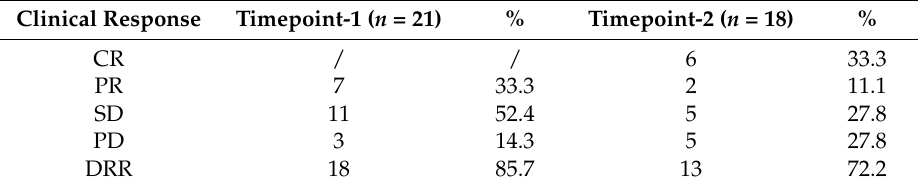
Table 4. Clinical response assessment according to the modified Response Evaluation Criteria for Solid Tumors (mRECIST) at timepoint-1 and timepoint-2. CR, Complete Response; PR, Partial Response; SD, Stable Disease; PD, Progressive Disease; DRR, Disease Response Rate = CR + PR + SD.